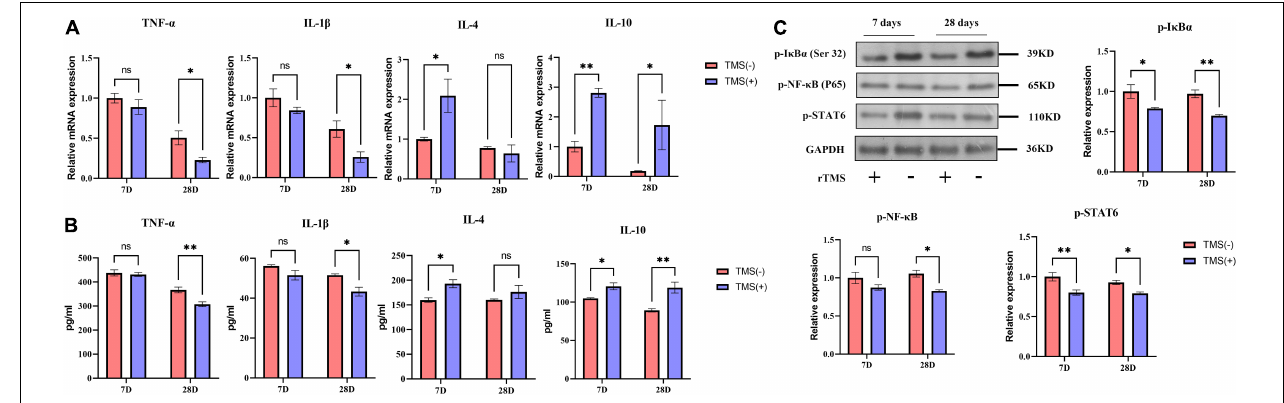
FIGURE 4 | Effects of rTMS on inflammation regulation in experimental ischemic rats. mRNA expression levels (A) and secretion (B) of inflammatory and anti-inflammatory cytokines in TMS (–) and TMS (+) groups ( n = 3). (C) Normalized expression of phosphorylation of nuclear factor of kappa light polypeptide gene enhancer in B-cells inhibitor, alpha (I κ B α ), nuclear factor kappa B (NF- κ B), and signal transducer and activator of transcription 6 (STAT6) in TMS (–) and TMS (+) groups ( n = 3). Data are shown as mean ± SEM. Statistical significance was determined with the unpaired Student’s t -test. * P < 0.05 and ** P < 0.01, and ns means no